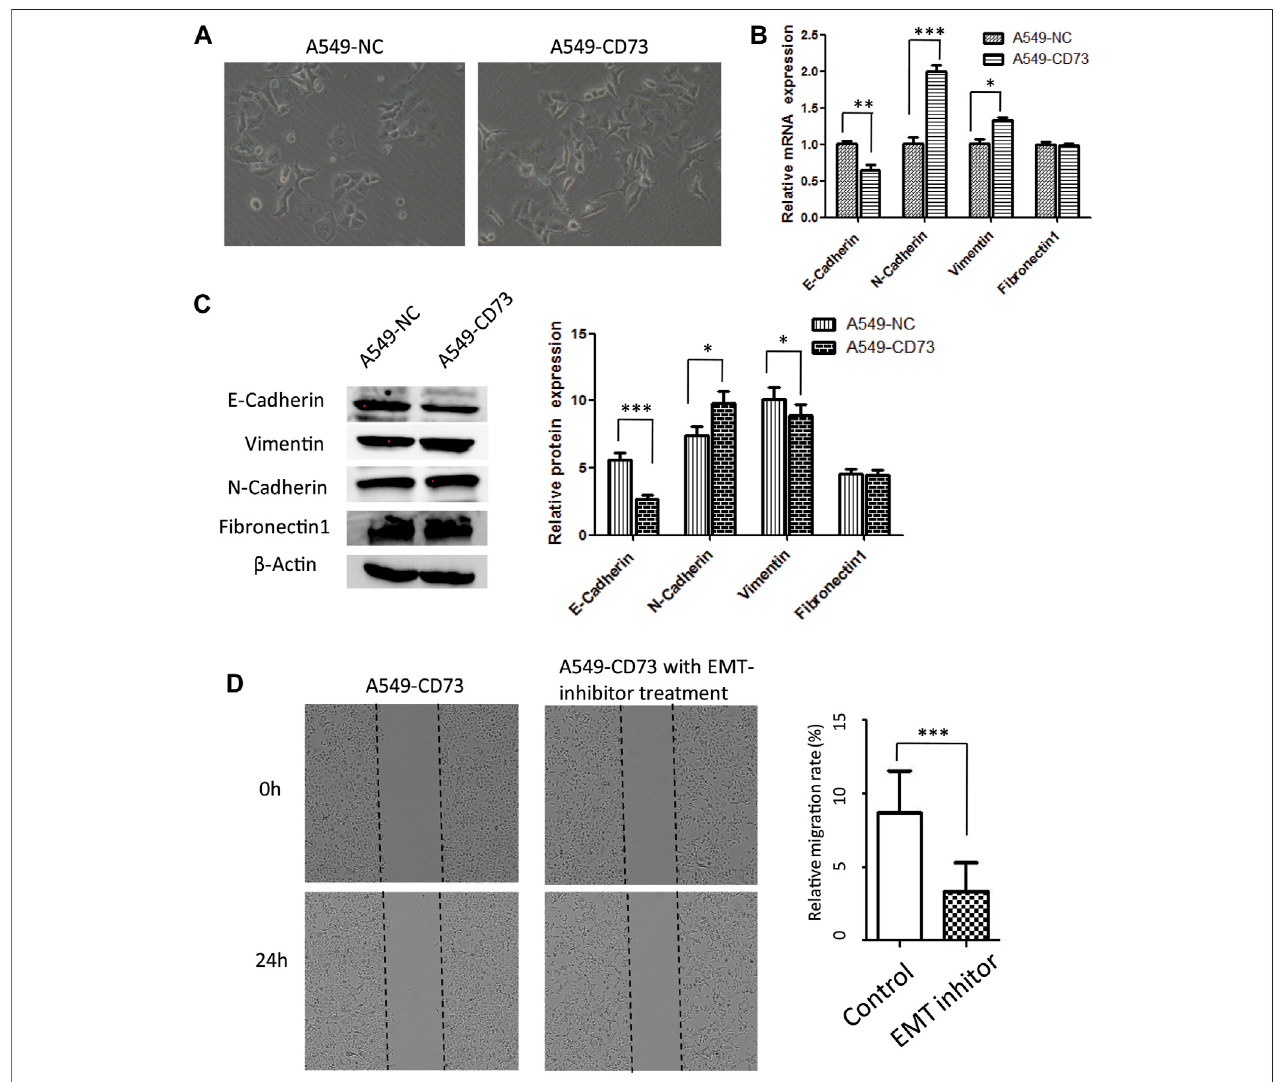
FIGURE 4 | CD73 ovexpression facilitates A549 EMT progression (A) The morphology of A549-CD73 and A549-NC. (B, C) EMT markers mRNA (B) and protein expression (C) levels in CD73 overexpression cells. (D) The effect of the EMT-inhibitor treatment on A549-CD73 cells migration.